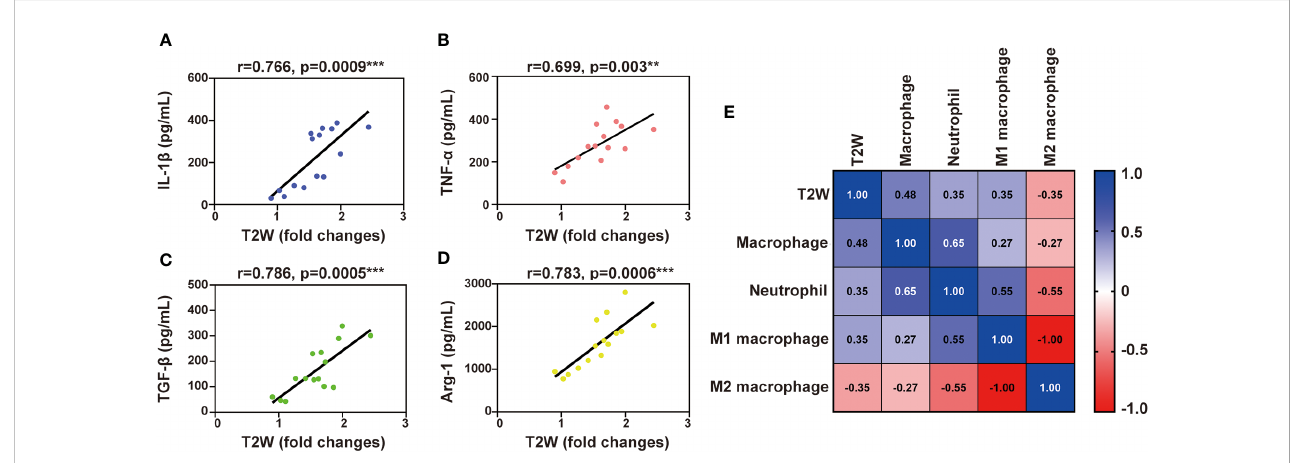
FIGURE 5 Liner correlation between myocardial T2W signal and in fl ammation mediator. (A-D) , scatter plot of myocardial T2W signal and IL-1 b (A) , TNF- a (B) , TGF- b (C) and Arg-1 (D) . (E) , heat map of neutrophils, MI macrophages, M2 macrophages and macrophages among myocardial T2W signal, ** p < 0.01, *** p < 0.001.